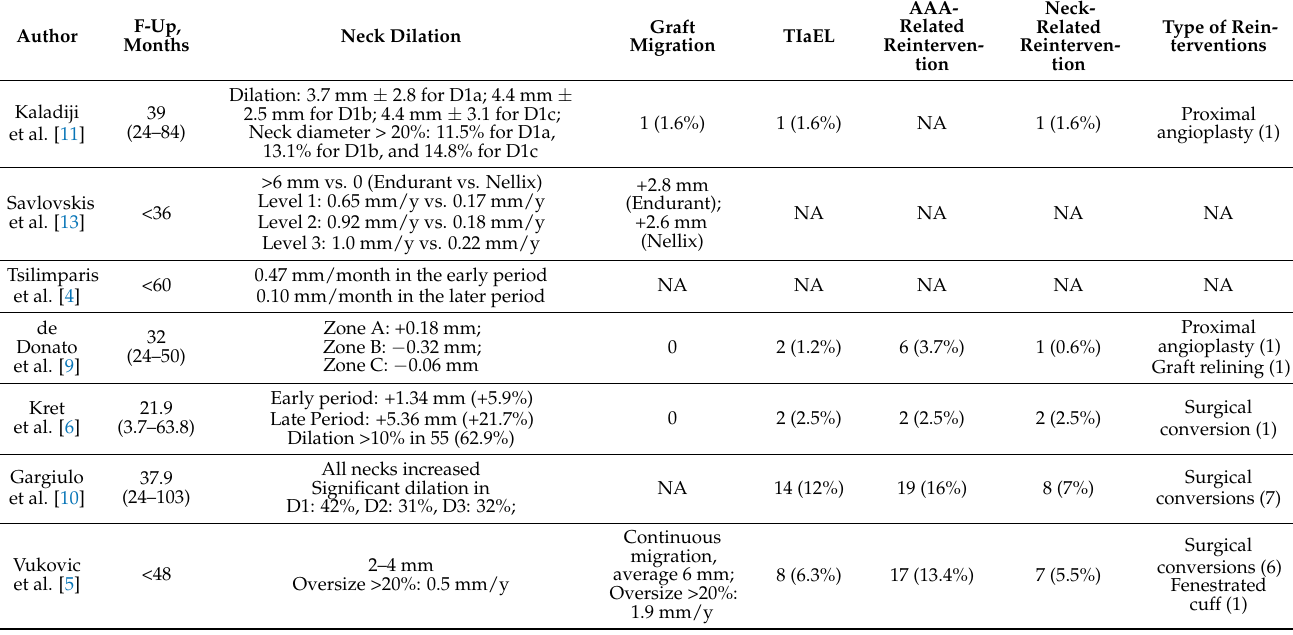
Table 4. Clinical